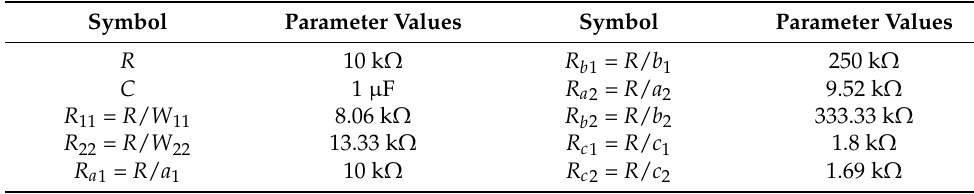
Figure 16. Circuit scheme of memristive HNN with synaptic crosstalk: ( a ) main circuit; ( b ) equivalent circuit of memristive synapse. Table 3. Parameter values of components.